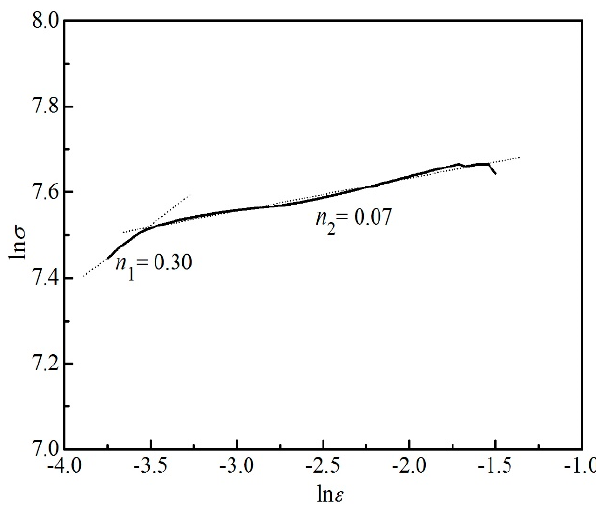
Figure 6. Relationship of ln σ and ln ε for the Ti 75 Fe 19 Sn 5 Mo 1 alloy.